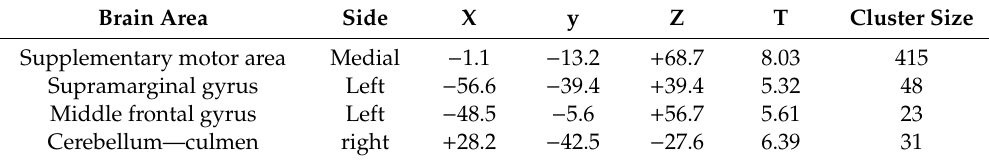
Figure 3. Brain structure (supplementary motor area) showing interaction between groups and sessions for MI task. Note: CBT—classical balance training, VBT—virtual reality balance training, CON—control group; asterisk indicates significant di ff erences between sessions. Table 2. Structures activated during the active contrast task in motor imagery (MI) conditions.